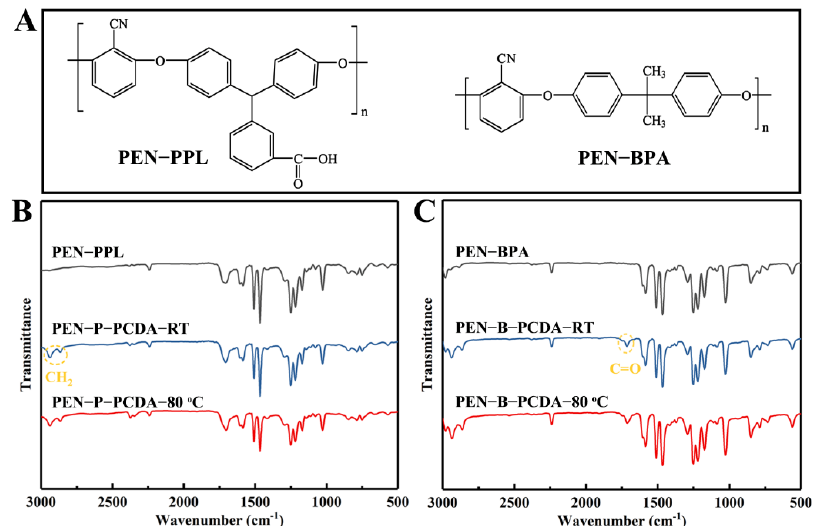
Figure 1. Chemical structures of PEN − PPL and PEN − BPA ( A ), FT − IR spectra of corresponding PENs and blended nanofibrous membranes at room temperature and after exposure to thermal stimulus (80 °C), PEN − P − PCDA ( B ) and PEN − B − PCDA ( C ).